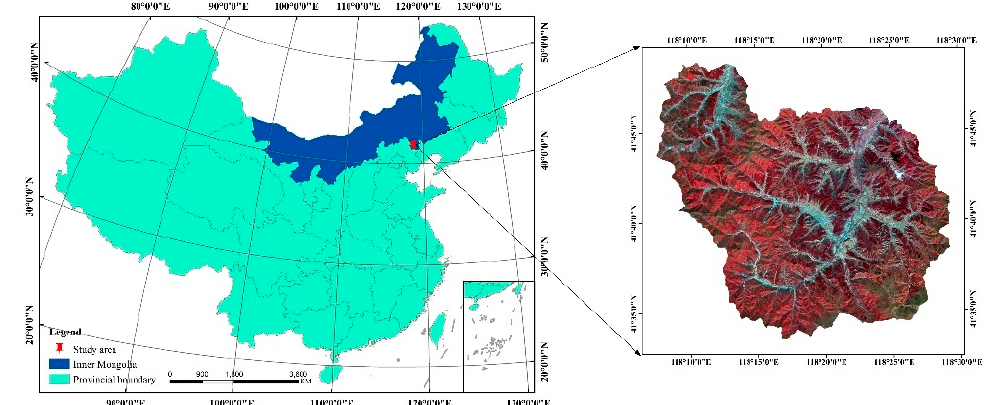
Figure 1. Schematic diagram of study area location and data source. WYD: Wangyedian forest farm; GF-2 satellite (bands 4, 3, 2 false-color combinations).